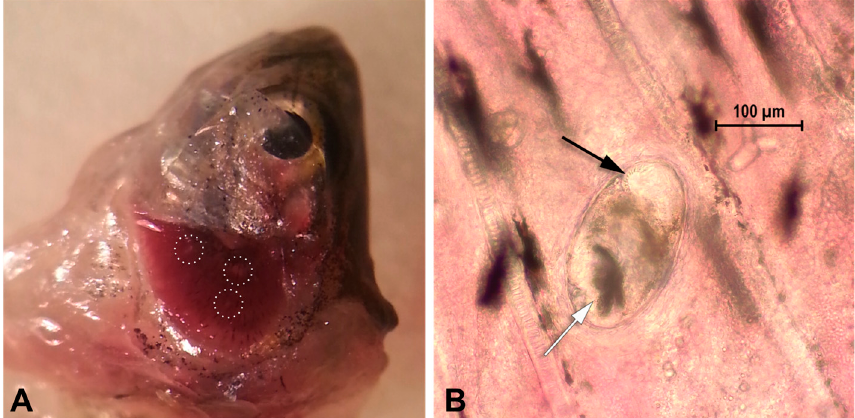
Figure 1. ( A ) Gills of an infected zebrafish. Parasitic cysts are visible as miliar white lesions on the gill tissue (dotted white lines); ( B ) Encysted metacercaria in the gill tissue of infected zebrafish. 40× microscopy evaluation. Note the X-shaped excretory bladder (white arrow) and part of the oral sucker (black arrow).